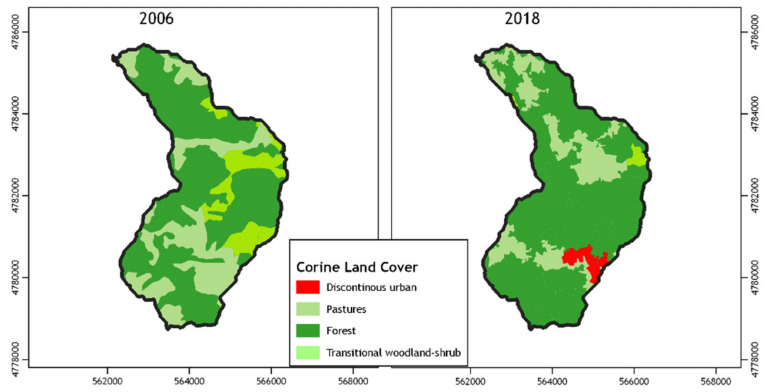
Figure 5. Land-use changes in the Corbeira catchment between 2000 and 2018.